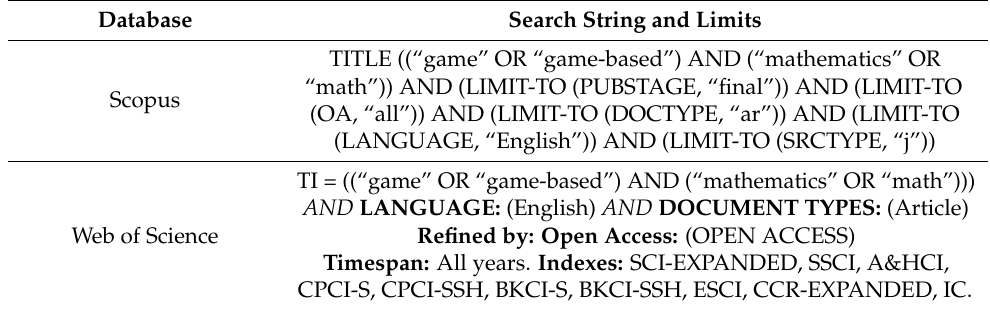
Table 2. The search strings and limits used for the electronic search